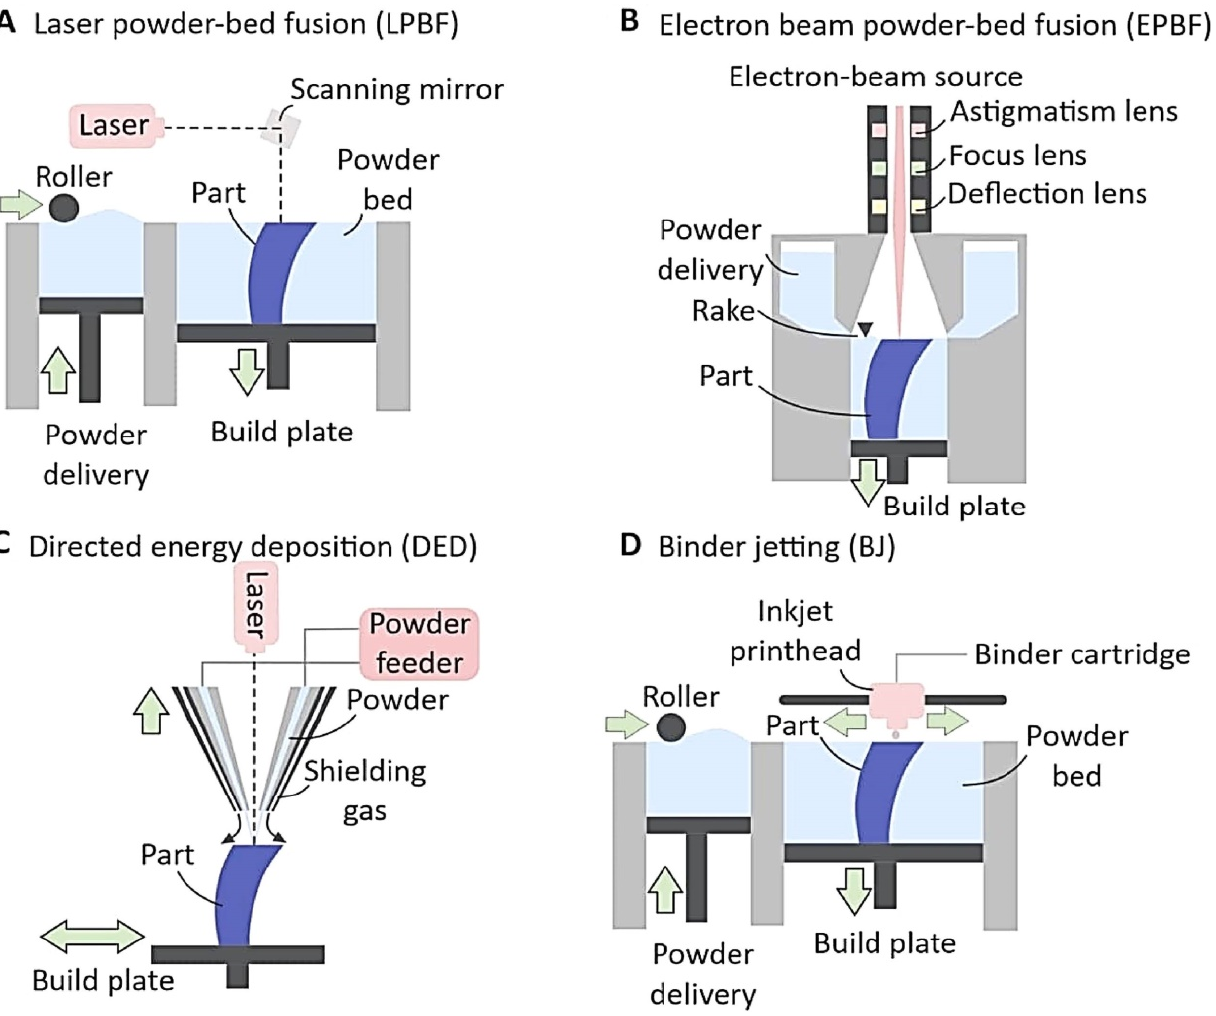
Figure 1. The well ‐ known processes for AM ‐ fabricated metallic implants: ( A ) laser powder ‐ bed Figure 1. The well-known processes for AM-fabricated metallic implants: ( A ) laser powder-bed fusion (LPBF), ( B ) electron ‐ beam powder ‐ bed fusion (EPBF), ( C ) directed energy deposition (DED) fusion (LPBF), ( B ) electron-beam powder-bed fusion (EPBF), ( C ) directed energy deposition (DED) with blown powder, and ( D ) the binder ‐ jetting (BJ) process. Reproduced and adapted from [64] with blown powder, and ( D ) the binder-jetting (BJ) process. Reproduced and adapted from [64]